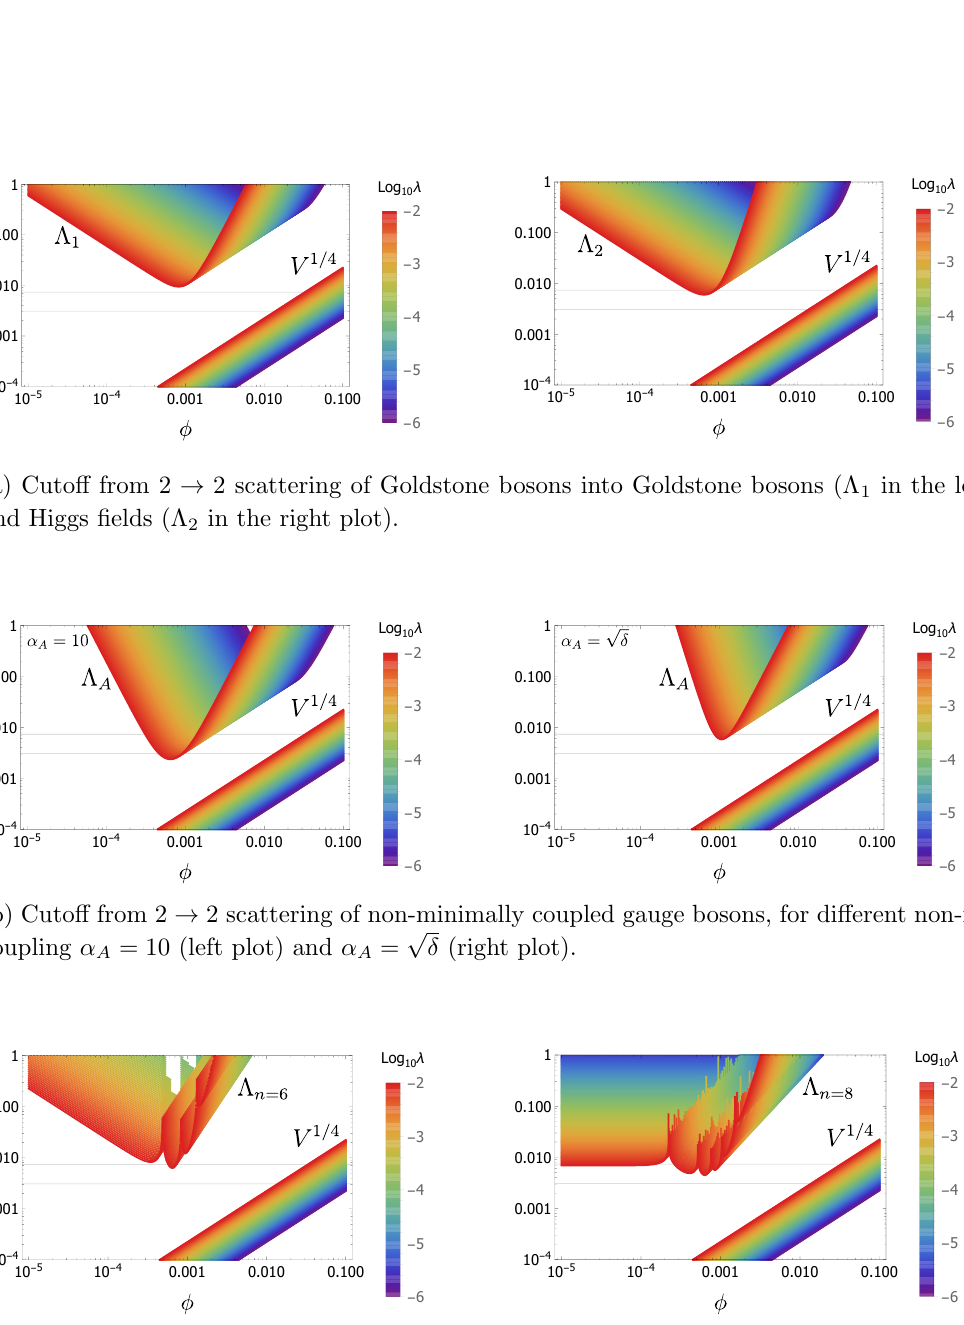
(c) Cuto(cid:11) from 2 ! n Higgs scattering, with n = 6 (left plot) and n = 8 (right plot).